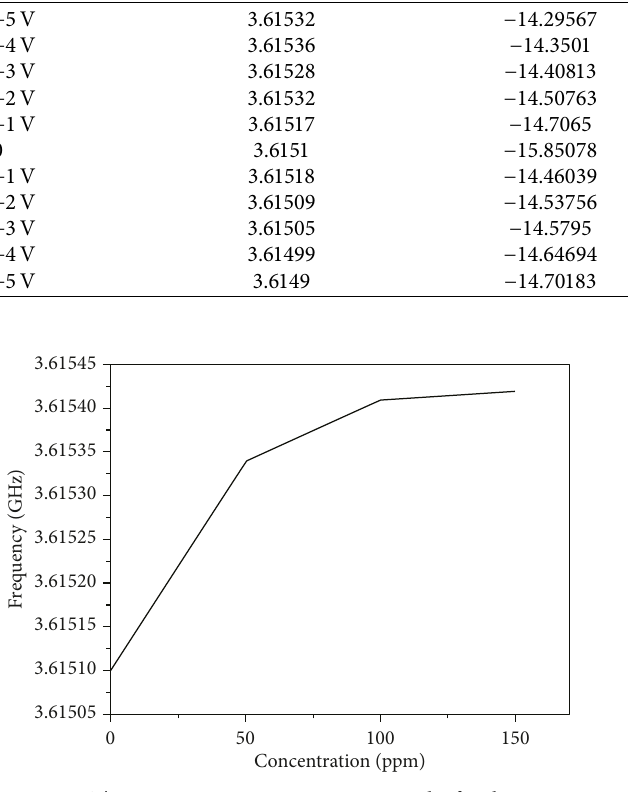
Figure 12: Te resonance frequency fgure of the AlN-based FBAR sensor before adding ethanol, the horizontal axis is frequency while the vertical axis is S 11 parameter.